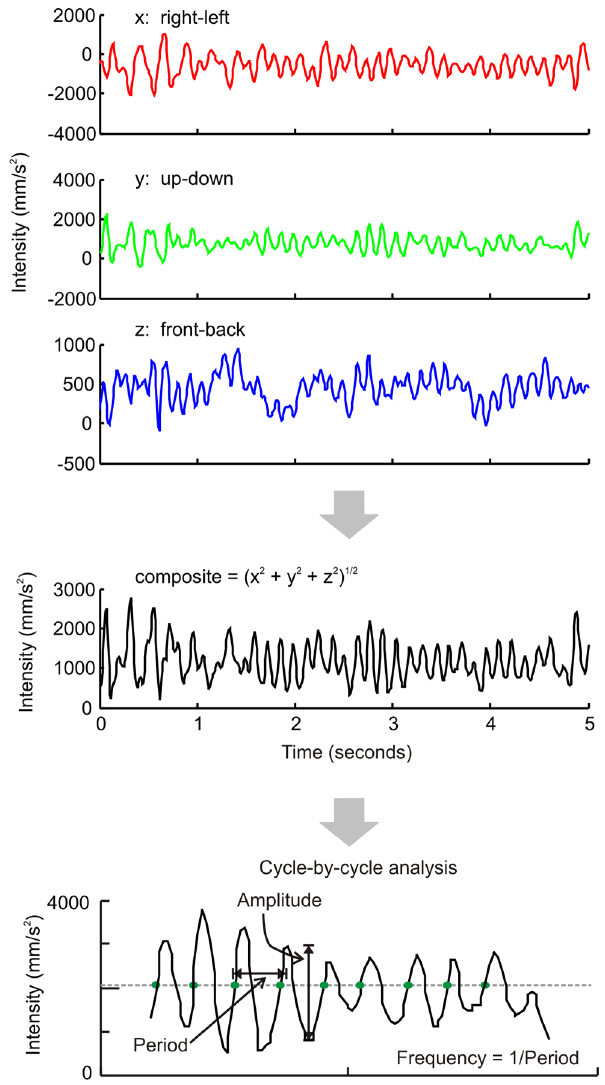
Figure 1. Outline of data analysis. (A) Limb acceleration is plotted on ordinate while corresponding time is plotted on abscissa. Each color depict one axis, black trace depicts sum of intensity vector depicting its composite value. Further analysis was performed on composite vectors. (B) This panel depicts algorithm to measure frequency of oscillations. The acceleration is first aligned to zero, then x-coordinate of the intercept between composite vector and zero-line (grey dashed line) is acquired (‘‘zero-crossing’’, red circles in the figure). Alternate value of such ‘‘zero-crossing’’ for acceleration value moving from low to high numbers are used to assess period. Latter is the time difference between two corresponding zero-crossings. Inverse of the period is frequency of given cycle. Population of single-cycle frequency is used to compute weighted mean, and standard deviation (irregularity) of the tremor frequency during given